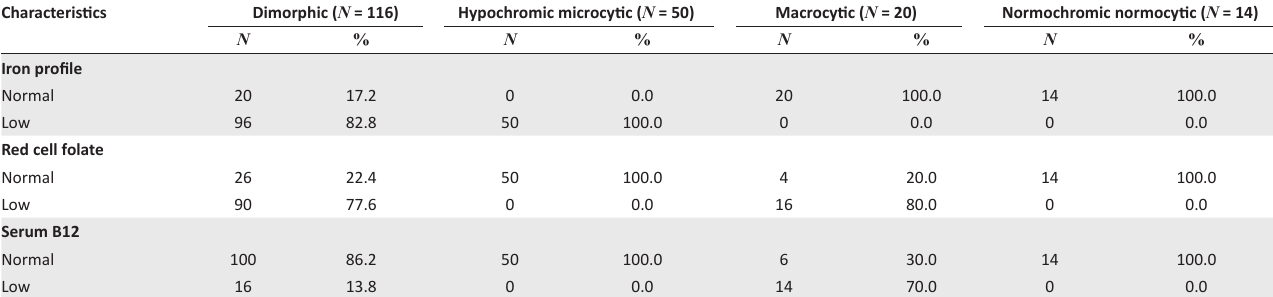
TABLE 3: Difference in morphological patterns of anaemia with iron profile, folate, vitamin B12 levels, Sudan, September 2016 to February 2017.